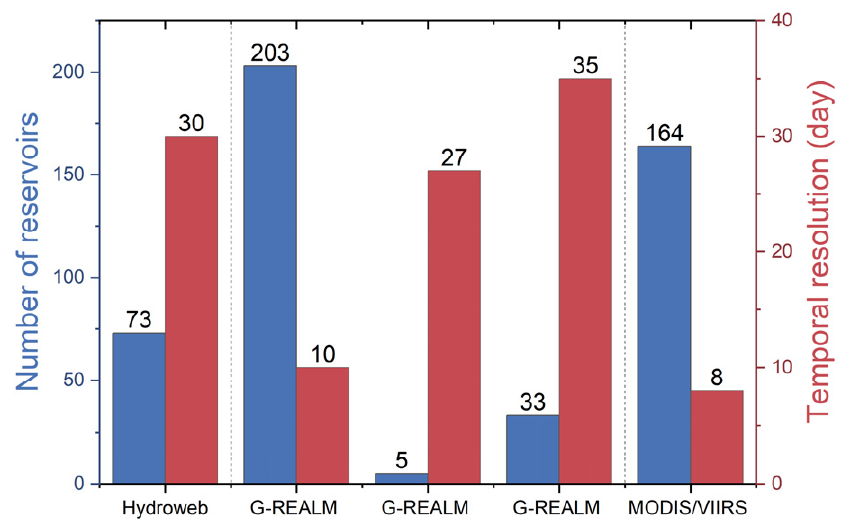
Figure 11. Comparison of reservoir coverage and temporal resolution of elevation measurements between satellite radar altimetry products (i.e., Hydroweb and G-REALM) and MODIS/VIIRS